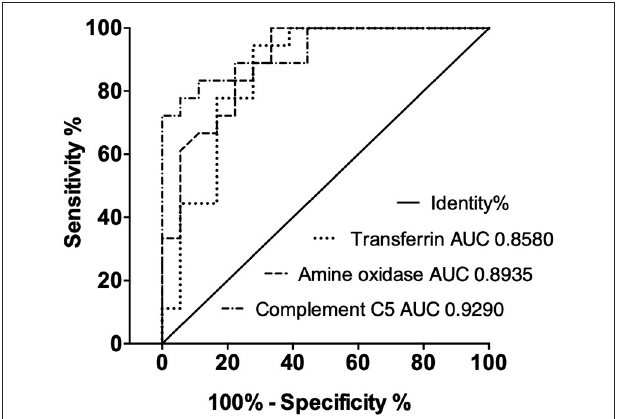
FIGURE 4 | Receiver-operating characteristic (ROC) curves of candidate biomarkers show good correct diagnosis indexes of ELISAs in clinical samples. The areas under the ROC curves (AUCs) are above